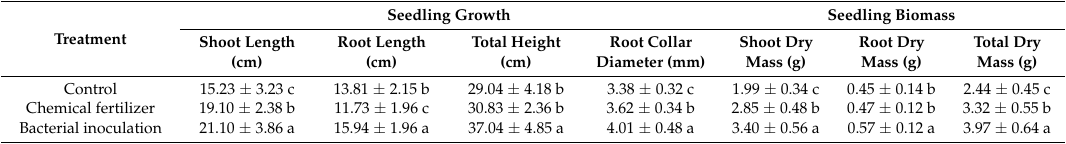
Table 2. Growth and biomass production of coastal pine seedlings for the control, chemical fertilizer, and inoculation with B. licheniformis MH48